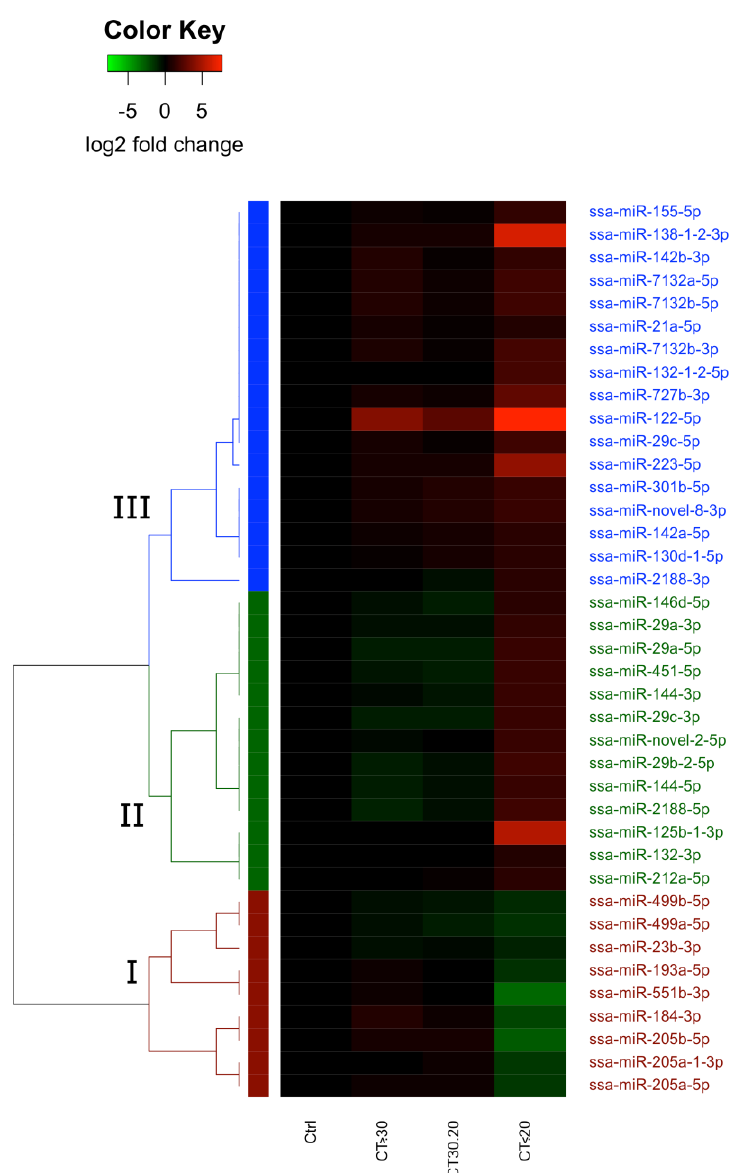
Figure 1. Heatmap showing results from clustering analysis of the gDE-miRNAs in the LS materials. Each line represents one gDE-miRNA, with the colour in each row representing the log2 fold change in abundance when compared to the control group. Major clusters of gDE-miRNAs are annotated as I (Cluster 1, red), II (Cluster 2, green), and III (Cluster 3, blue).